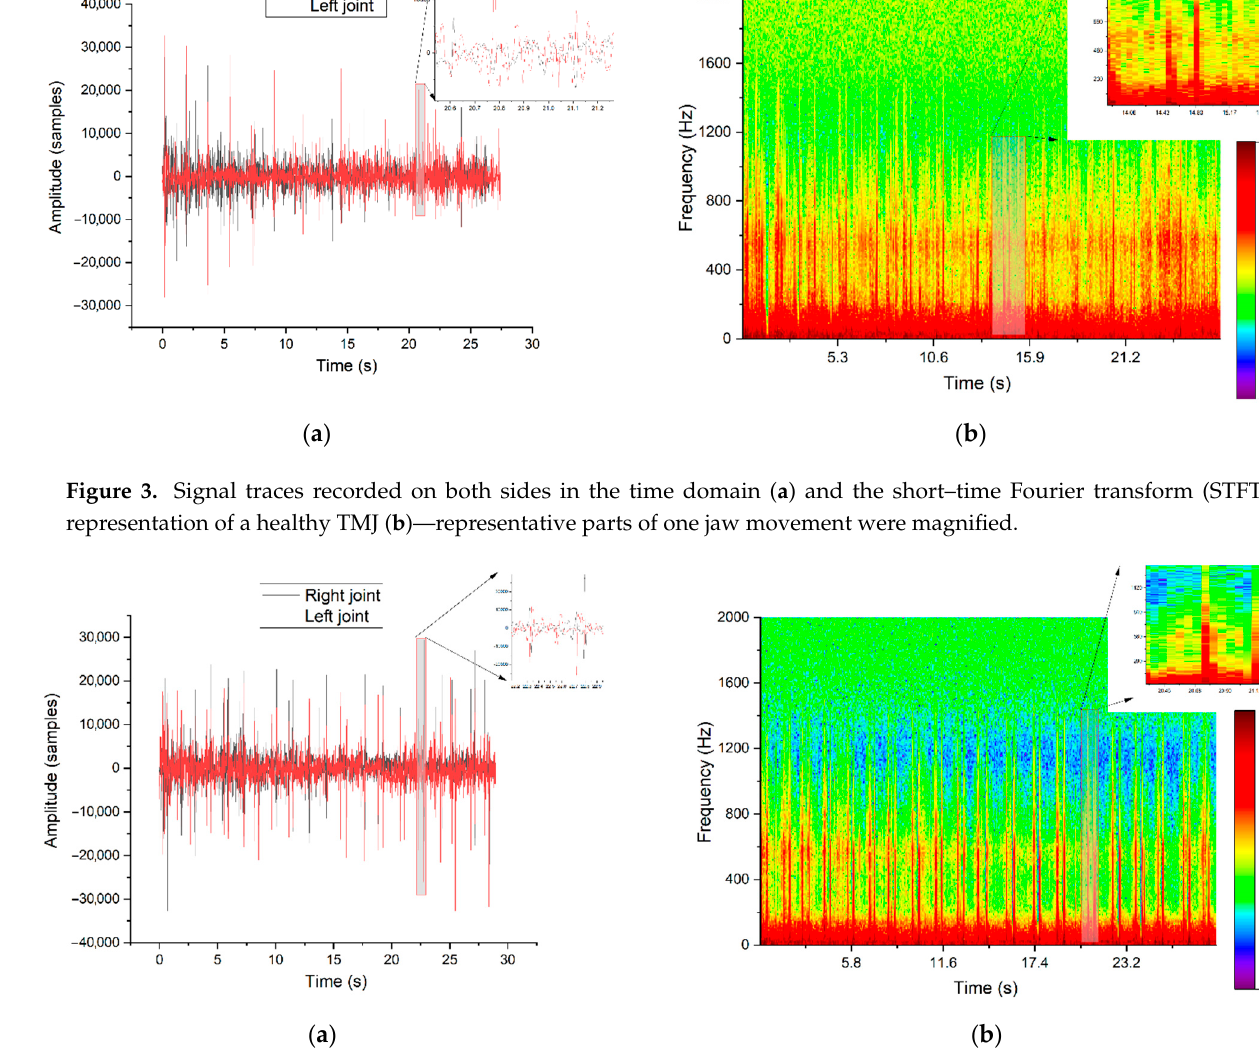
( b ) Figure 5. Signals traces recorded on both sides in the time domain ( a ) and STFT representation of TMJH manifested as a high-amplitude double-peak waveform ( b )—representative parts of one jaw movement were magnified. Figure 4 depicts the original TMD sound with a visible significant peak waveform, which is typical for TMD. Another observation is that the amplitudes of vibrations corre- sponding to the joint movement between extreme positions are very low. Movements of TMJ structures of a healthy person are smooth and almost soundless according to the tra- ditional auscultation criteria. As previously stated, the analysis of the non-stationary sig- nals requires the observation of frequency changes as a function of time, which can be achieved through the application of time–frequency representation (spectrogram). As a result, characteristic frequencies can be distinguished in each section of the recorded joint movement. As mentioned, synchronised signal traces recorded on the left and right sides differ. Both TMJ and TMD generate sounds independently but a kind of crosstalk signal propagated by tissues from opposite sides should be taken into account; this is discussed in the literature [20]. Based on the obtained result in comparison with the physician’s ob- servation and diagnosis, we can propose time–frequency representation as the most rele- vant. As highlighted in the figures, the diagnostic information of each recording is placed in a specific frequency and time range which directly corresponds with the movement stage.